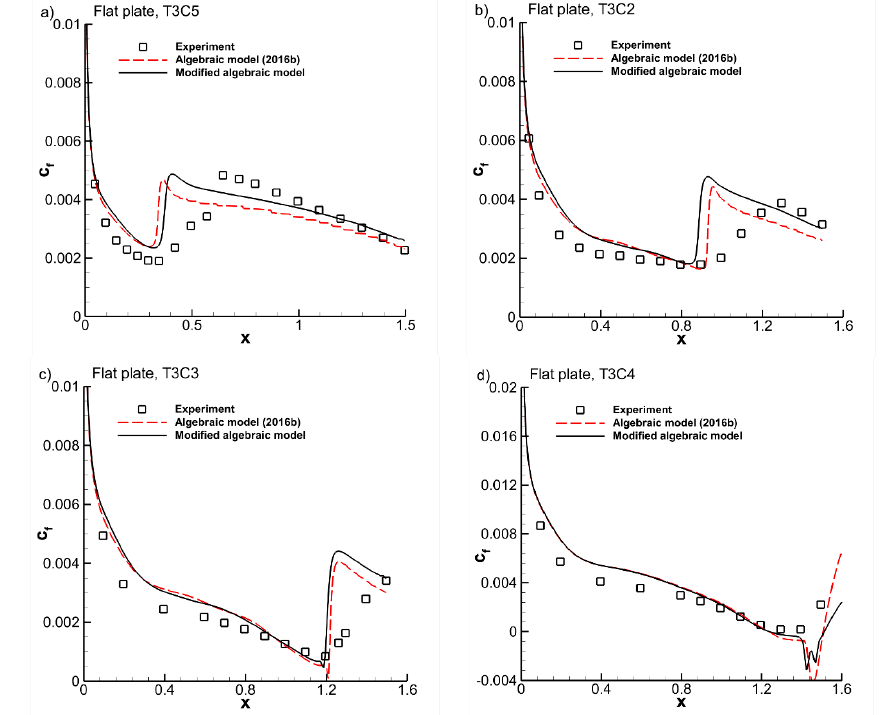
Figure 10. Skin friction of the ERCOFTAC flat plate cases for ( a ) T3C5, ( b ) T3C2, ( c ) T3C3 and ( d ) T3C4 cases.